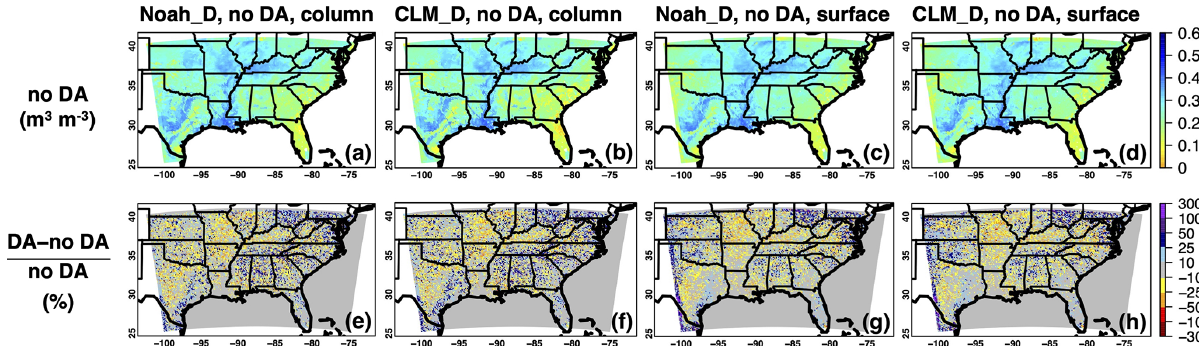
Figure 2. Period-mean (16–28 August 2016) WRF-Chem (a, b) column-averaged and (c, d) surface-layer soil moisture fields at initial times and (e–h) their relative changes in percent due to the SMAP DA. Results based on the Noah_D and CLM_D cases are shown in (a) , (c) , (e) , and (g) and (b) , (d) , (f) , and (h) ,